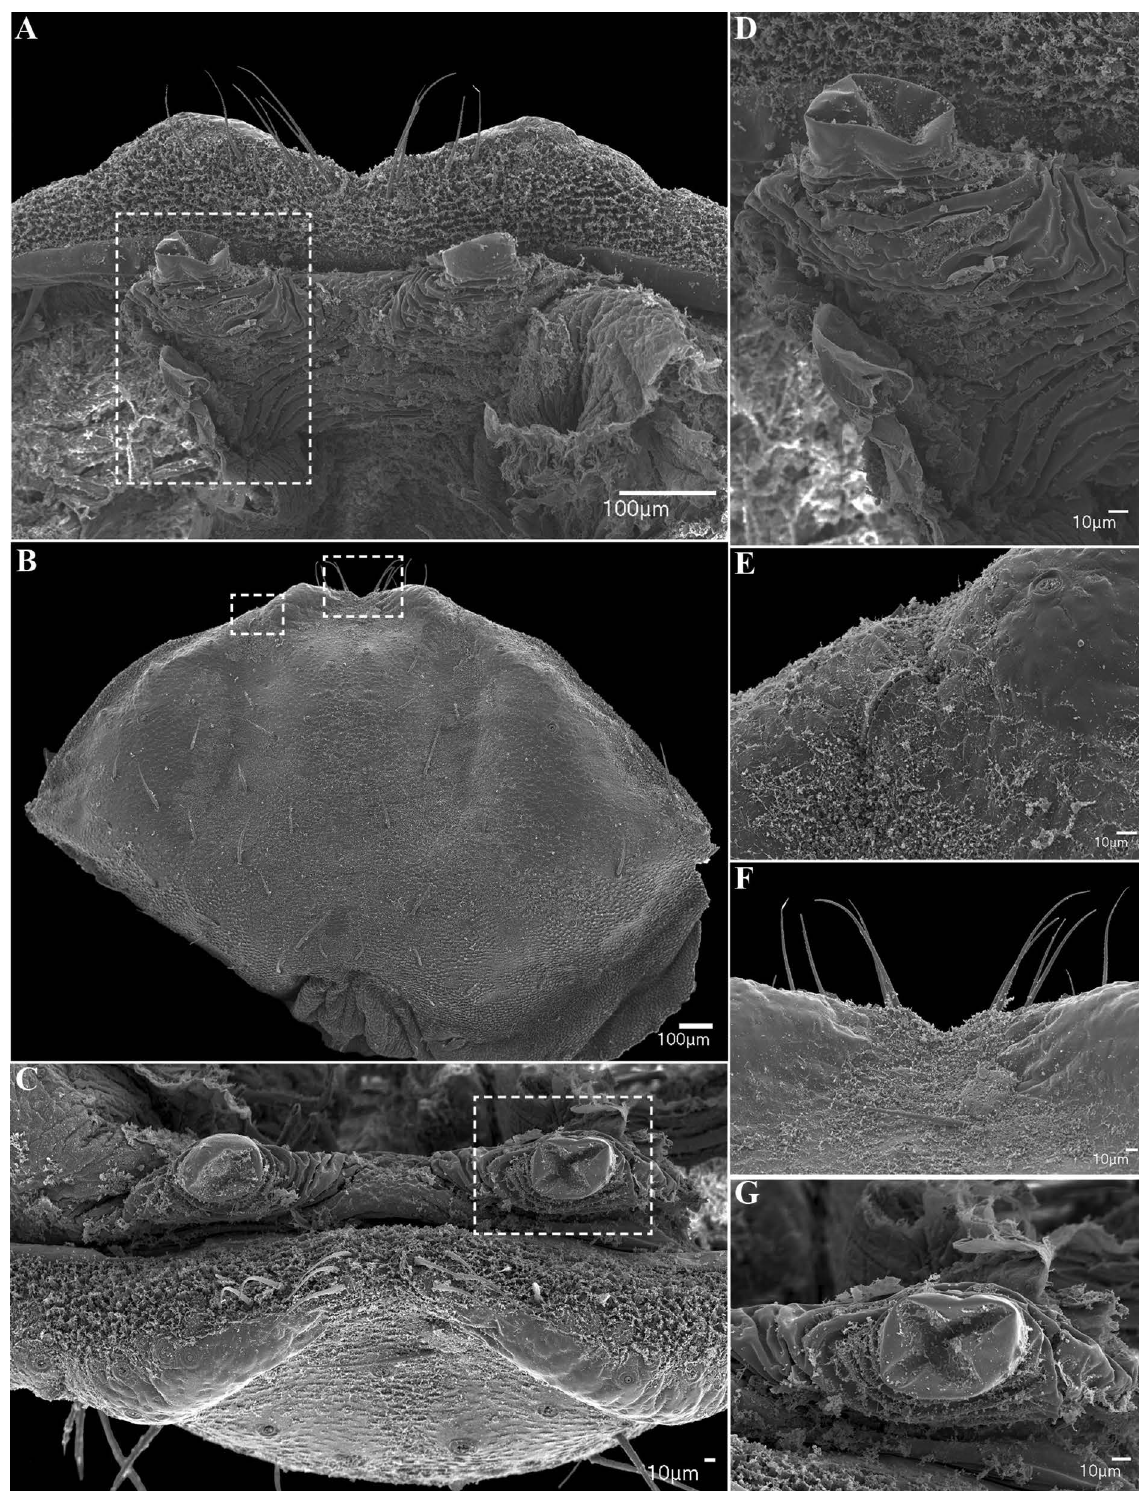
Fig. 132. Sarax yayukae Rahmadi, Harvey & Kojima, 2010 (AMCC [LP 12109]), female gonopod and genital operculum. A . Plunger-like gonopod, dorsal view. B . Posterior margin of genital operculum, ventral view. C . Gonopods, posterior view. D . Sinistral gonopod. F . Glandular openings on margin of genital operculum. G . Genital operculum between gonopods. G . Sinistral gonopod, posterior